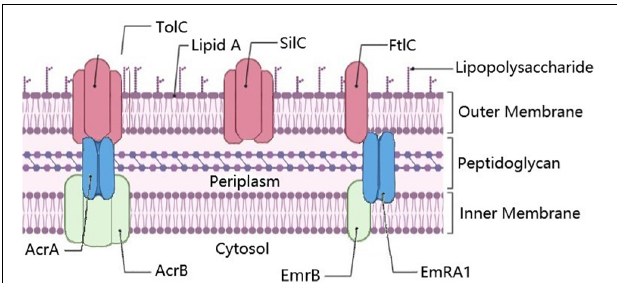
FIGURE 1 | Annotated efflux pump genes in Francisella . The membrane fusion proteins AcrA and EmrA1 proteins are shown in blue, the plasma membrane fusion proteins AcrB and EmrB in Green, and outer membrane proteins TolC, SilC, and FtlC in pink. SilC may also pair with EmrA1 and EmrB, especially as they are co-localized in the chromosome. Known trimers illustrated as such. Figure created using BioRender (https://biorender.com/).